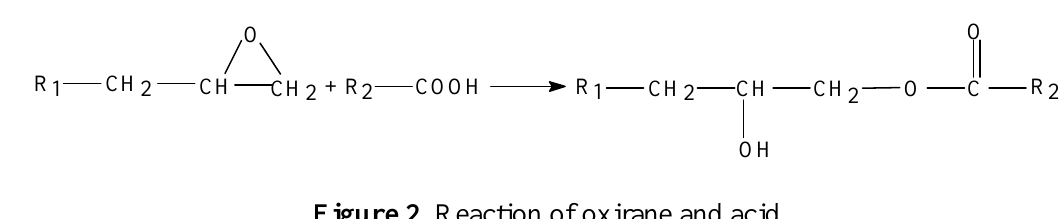
Figure 2 . Reaction of oxirane and acid